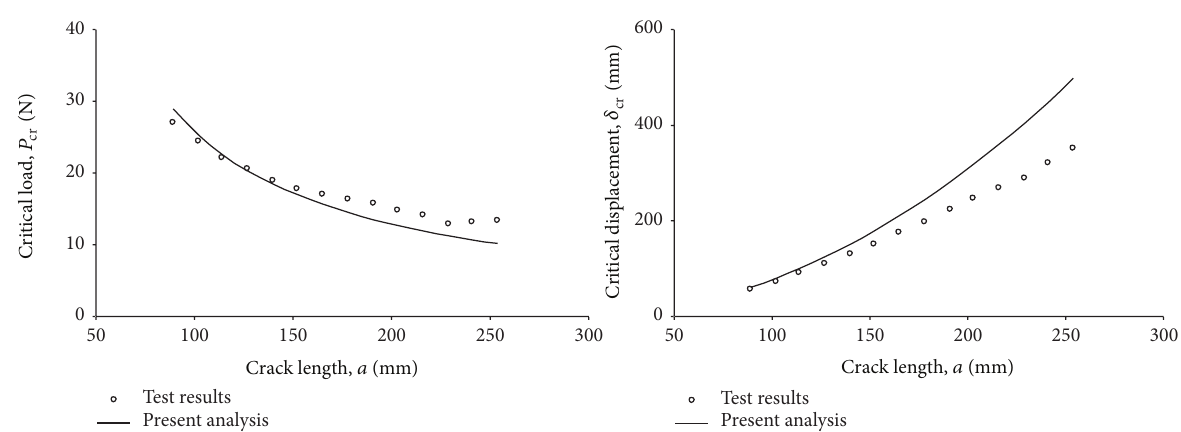
) and the corresponding displacement (𝛿 ) cr cr